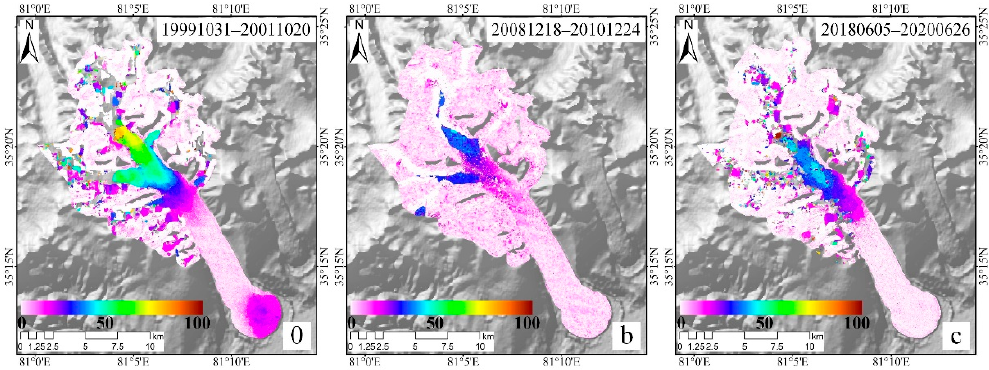
Figure 4. Flow velocities (m yr − 1 ) of the Chongce Glacier during the periods of 9 October 1994–25 October 1994 ( a ), 25